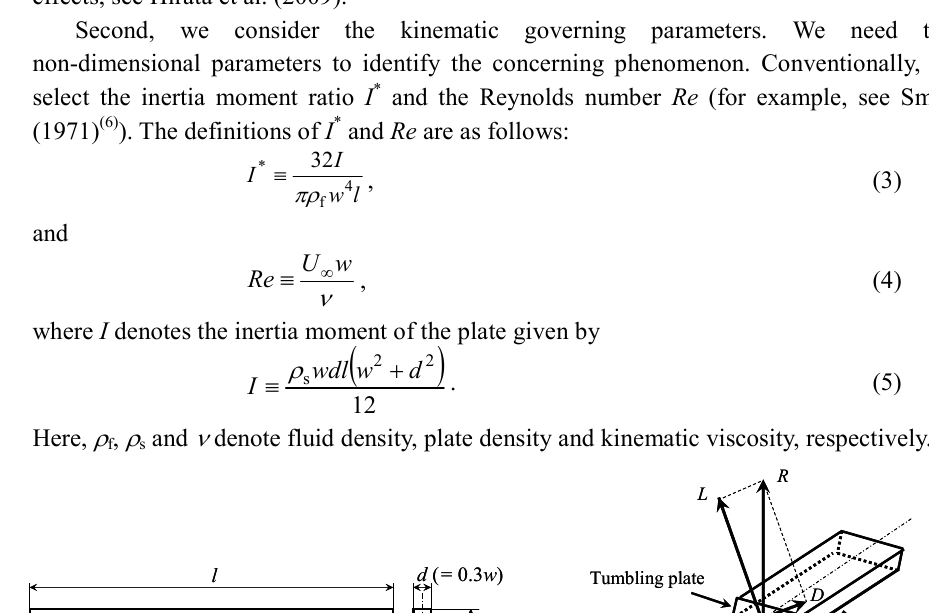
Falling direction w w U ∞ Fig. 2 Schematic diagram of the tumbling of a plate and acting forces, together with the coordinate system.